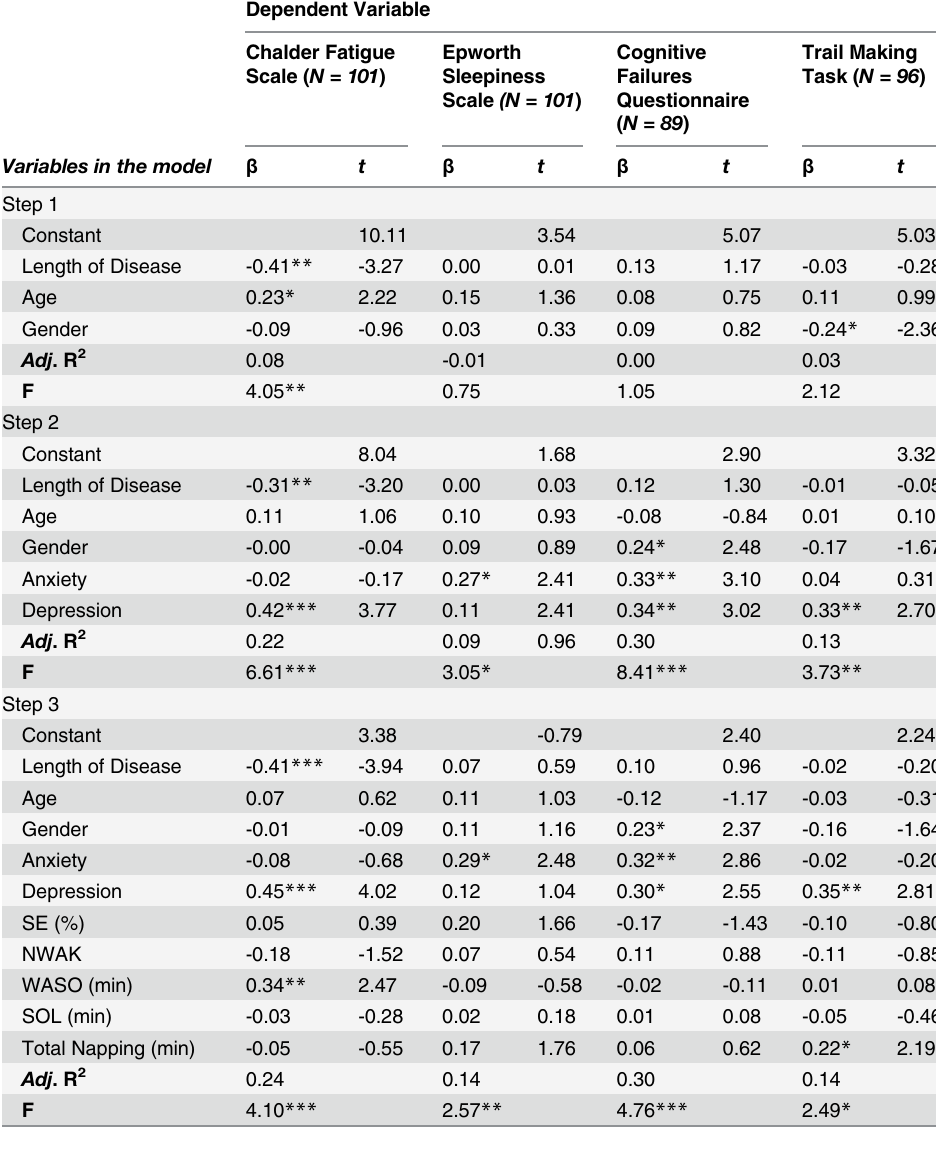
Table 3. Hierarchical regressions for the dependent variables; Chalder Fatigue Scale, Cognitive Failures Questionnaire, Trail Making Task and Epworth Sleepiness